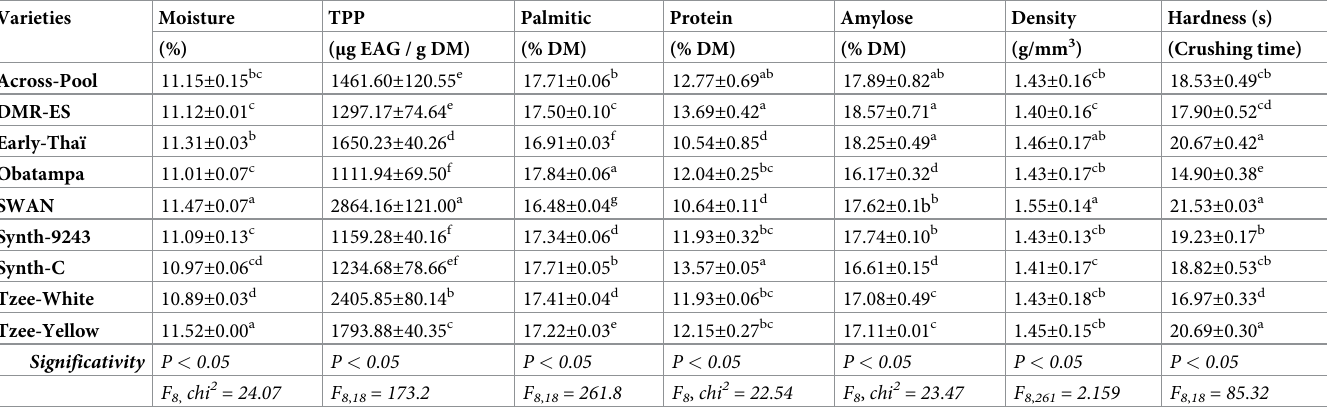
Table 3. Physicochemical characteristics of maize